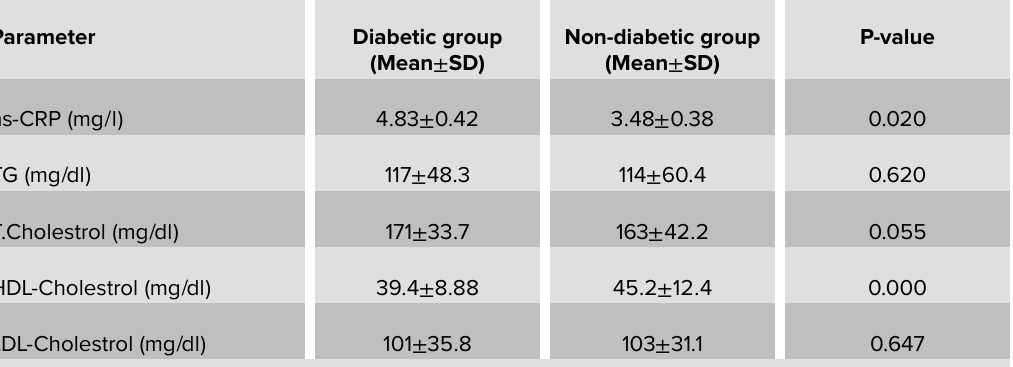
Table 2: Compersion of serum hs-CRP and lipid profile in diabetic and non-diabetic